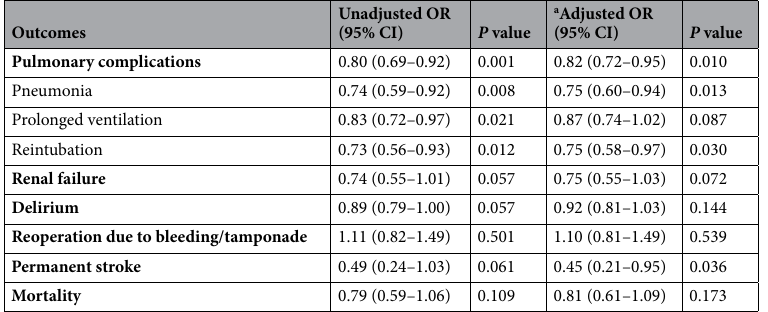
Table 3. Odds ratio for the creatinine/cystatin C ratio per 10 units (continuous variable) for the occurrence of postoperative complications. a Adjusted by EuroSCORE II. OR, odds ratio; CI, confidence interval.